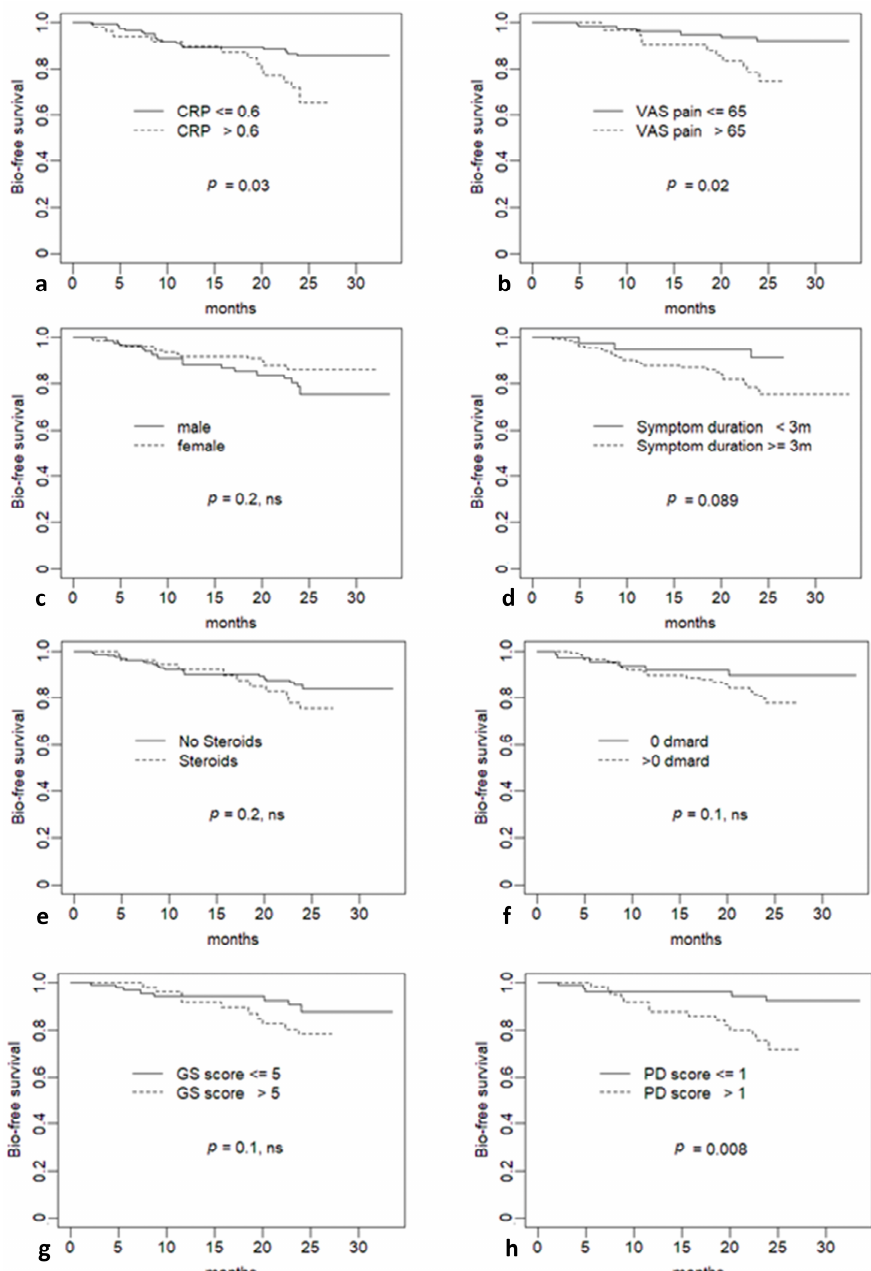
Figure 2. Survival curves (outcome: initiation of ts/bDMARDs) for baseline variables. ( a ) C reactive protein; ( b ) visual analogue scale for pain pain; ( c ) gender; ( d ) symptom duration; ( e ) treatment with glucocorticoids; ( f ) tratment with csDMARDs; ( g ) ultrasound grey scale score; ( h ) ultrasound power Doppler score. M: months; CRP: C reactive protein; VAS: visual analogue scale; DMARD: disease modifying anti rheumatic drug; GS: grey scale; PD: power Doppler.